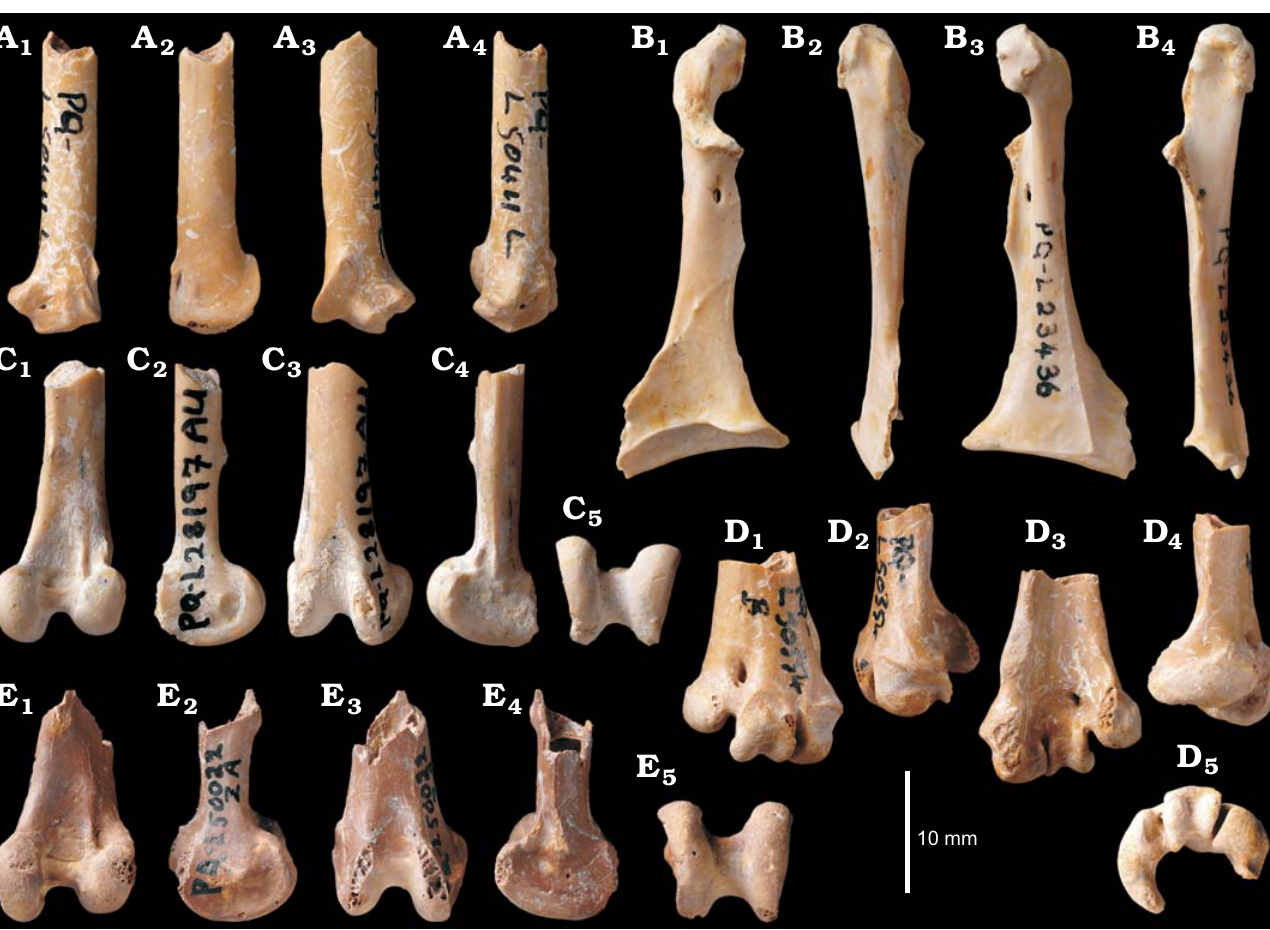
Fig. 1.Tytonid owl Tyto richae sp. nov. from the early Pliocene, Upper Varswater Formation at Langebaanweg, South Africa; paratypes ( A – C , E ), holotype ( D ). A . Left ulna (SAM-PQ-L50411 L), in dorsal (A (B ), lateral (B ), medial (B ), and ventral (B 1 2 3 and distal (C ) views. D . Right tarsometatarsus (SAM-PQ-L50354 B), in dorsal (D 5 tibiotarsus (SAM-PQ-L50022 ZA), in cranial (E